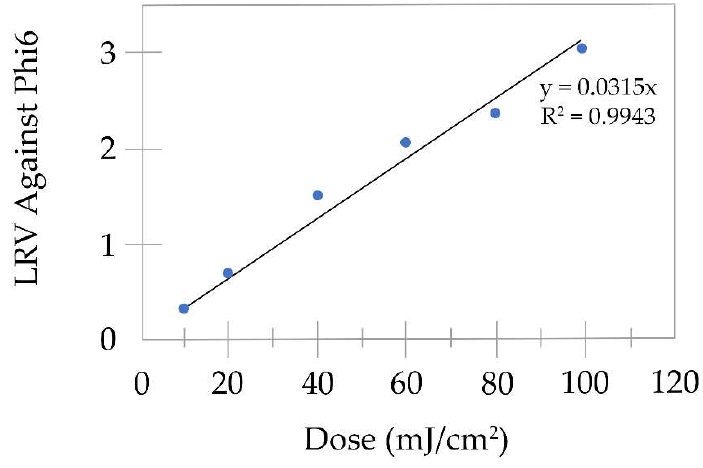
Figure 5. The dose response curve of bacteriophage Phi6 as measured against array with peak wavelength of 267 nm in aqueous solution in a Petri dish. Experiments were done in triplicates and means used in graphing.